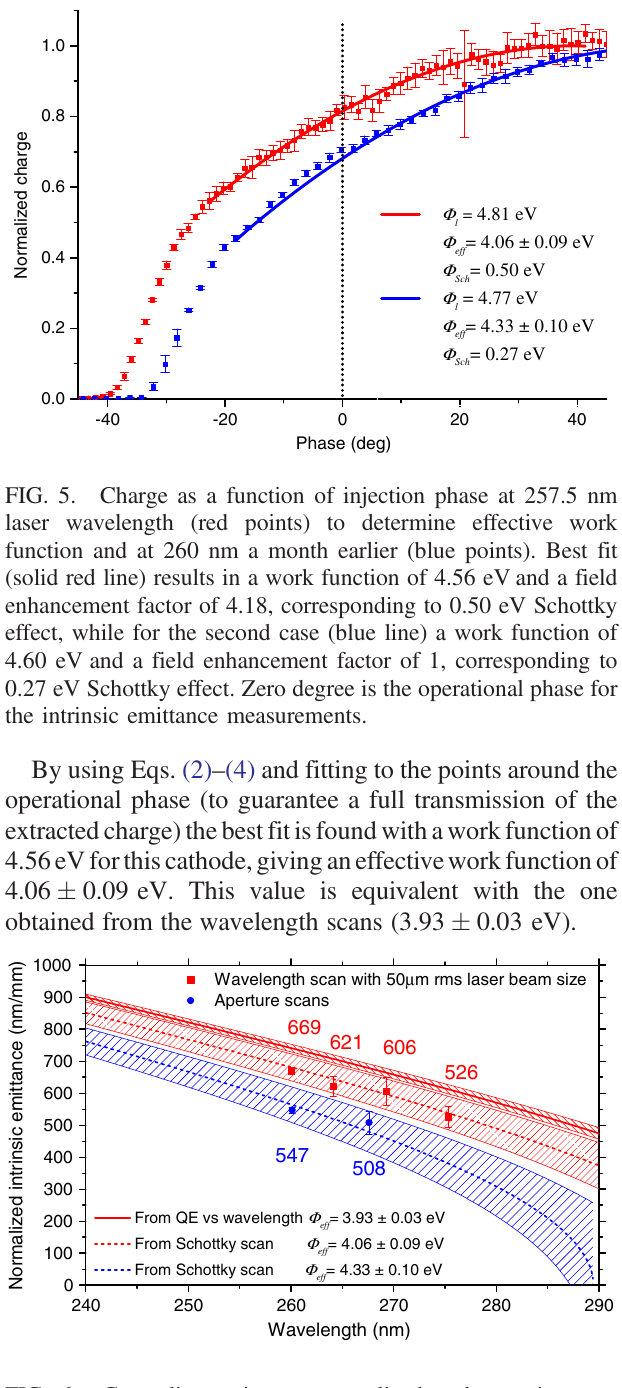
FIG. 6. Core slice emittance normalized to beam size as a function of wavelength for the Cu_3 cathode. Measurements with the smallest aperture below space-charge limit, at 1 pC (red squares). Fits with intrinsic emittance calculated from the effective work functions determined from the QE measurements as a function of wavelength shown in Fig. 4 (solid red line with error band) and from the Schottky measurements (dashed red line with error band). Two points derived from the laser beam size scan a month earlier shown in Fig. 2 (blue dots) with the fit from the Schottky scan performed at the same time (dashed blue line with error